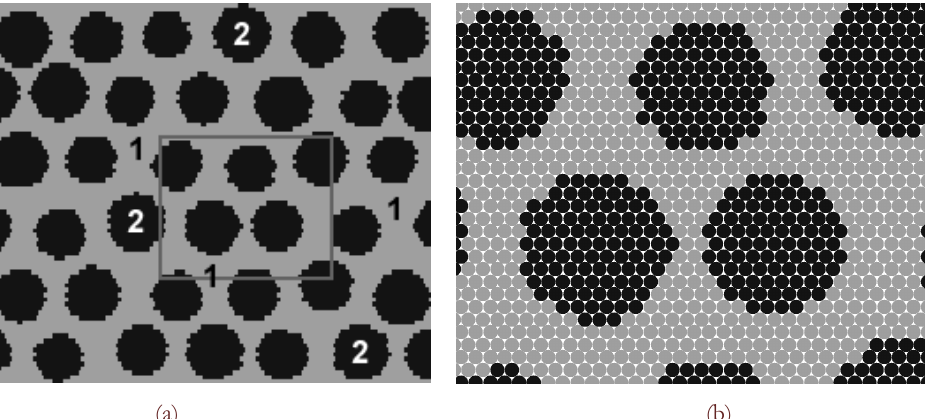
Figure 9: Structural model of metal-ceramic composite: (a) general view and (b) enlarged area inside of grey rectangle in (a). Main constituents of the structure are: nickel-chromium plastic binder (1) and high-strength brittle TiC particles (2).